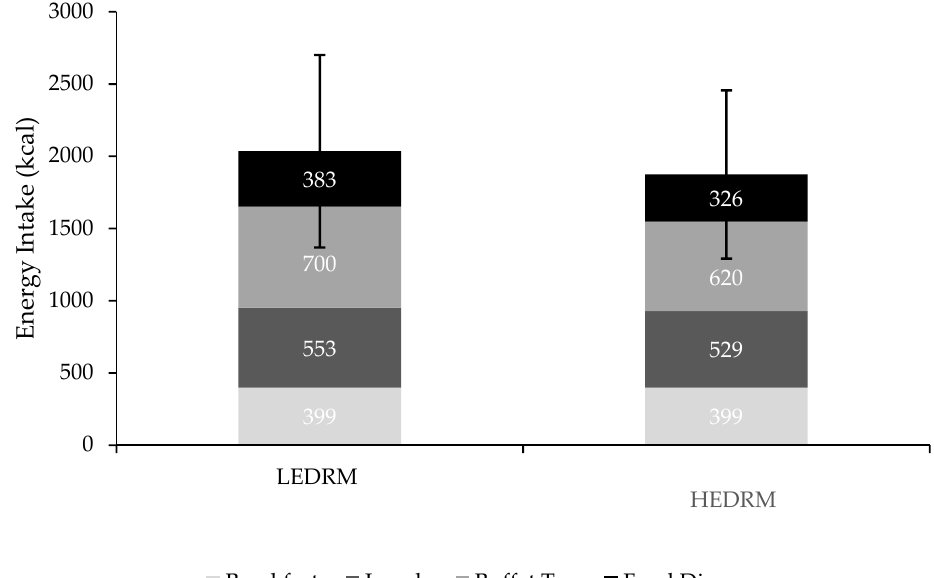
Figure 5. Mean energy intake (kcal) from breakfast, test lunch, buffet meal, and food diary during the low-energy-dense ready meal (LEDRM) test day and the high-energy-dense ready meal (HEDRM) test day. Table 2. Nutritional composition of food intake during the buffet meal and during the whole test days (breakfast, lunch, buffet tea and weight food diary combined) during the